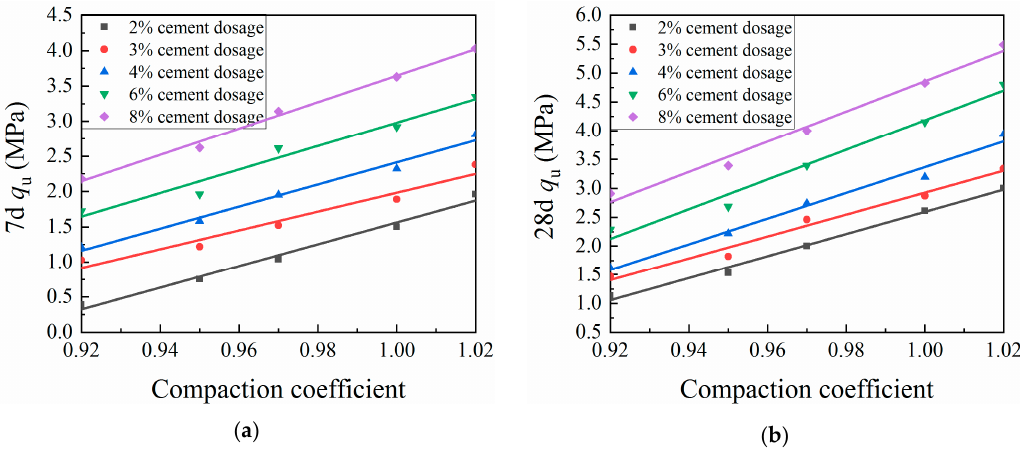
Figure 8. Relationship between compaction coefficient and unconfined compressive strength (UCS) of cement-modified loess (CML): ( a ) seven-day (7d) UCS; and ( b ) twenty-eight-day (28d) UCS.